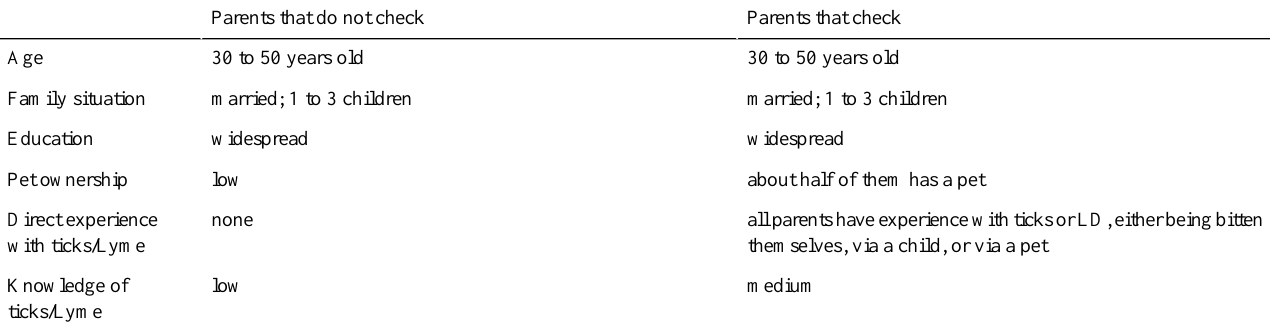
Table 2. Characteristics of parents and their